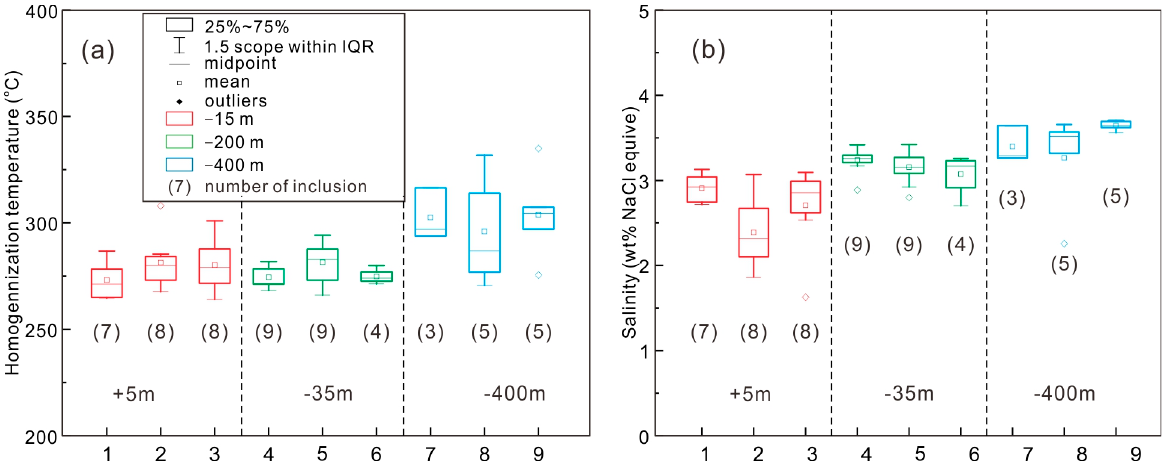
Figure 14. Analysis results of quartz fluid inclusions. ( a ) Temperature maps of quartz fluid inclusions at various depths; ( b ) Salinity maps of quartz fluid inclusions at various depths.